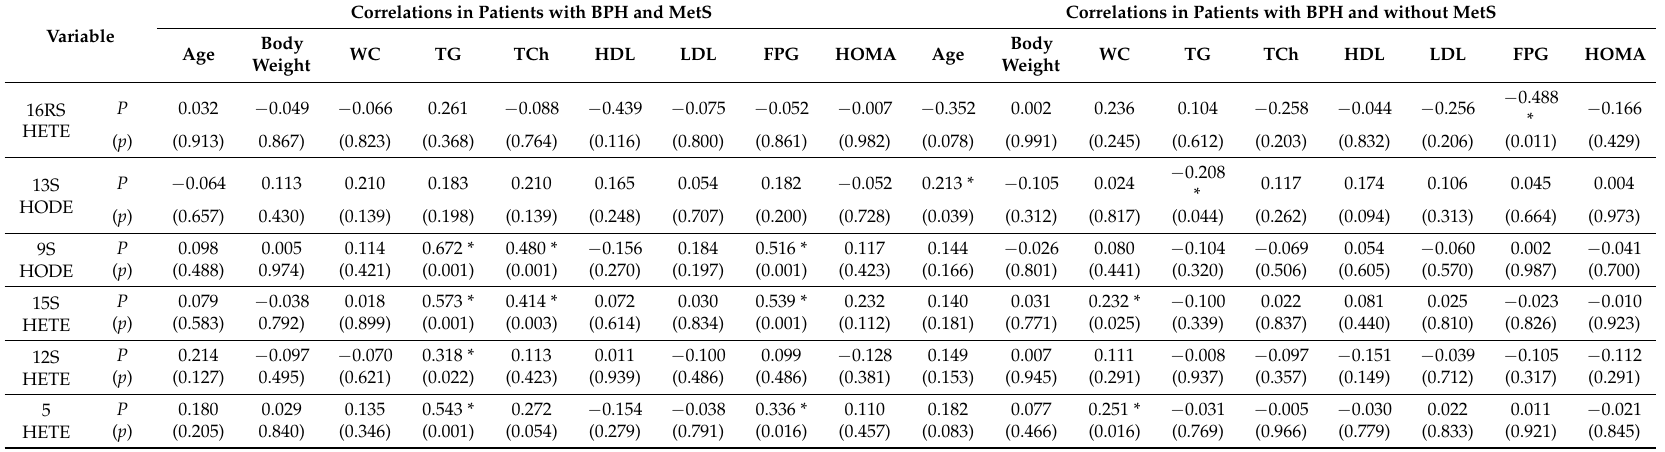
Table 3. Correlations between anthropometric and metabolic parameters and the levels of the selected fatty acids in BPH patients with and without MetS. Correlations in Patients with BPH and MetS Correlations in Patients with BPH and without MetS Variable